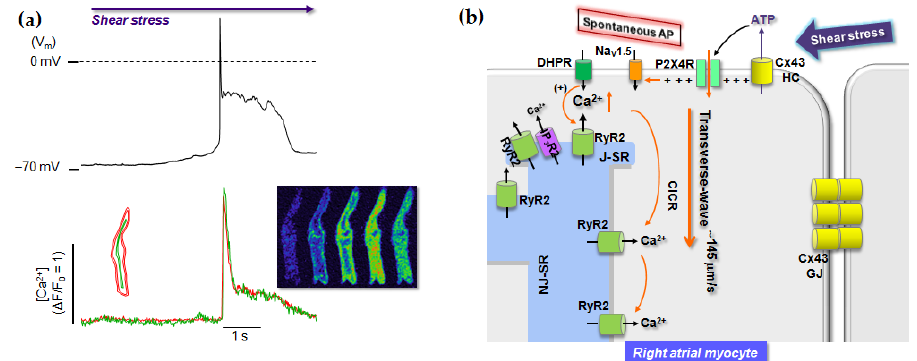
Figure 1. Role of P2X4 receptor in shear stress-induced action potential in rat cardiac atrial myocytes. ( a ), shear stress-induced atrial action potential (upper) and Ca 2+ releases (lower) simultaneously measured in a right atrial (RA) myocyte from rat. Red and green traces represent peripheral and central Ca 2+ signals, respectively, measured from ROI shown in the left side of traces, showing transverse Ca 2+ wave (see confocal Ca 2+ images on the right side). (modified from [9]) ( b ), Schematic diagram representing hypothetical shear stress signaling pathway associated with transverse Ca 2+ wave. The signaling is known to start from the same ATP release via connexin 43 (Cx43) hemichannels (HC) and subsequent activation of P2X4 receptor (P2XR). Cation influx though P2X4 receptor channel can depolarize membrane potential to trigger spontaneous action potential and secondary transverse Ca 2+ wave. (modified from